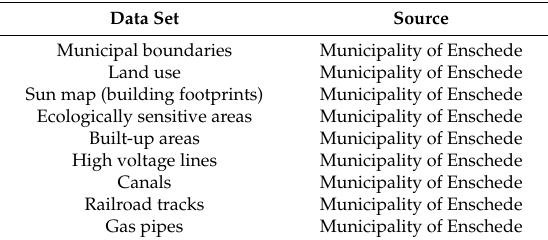
Table 1. Complete list of data sets used.